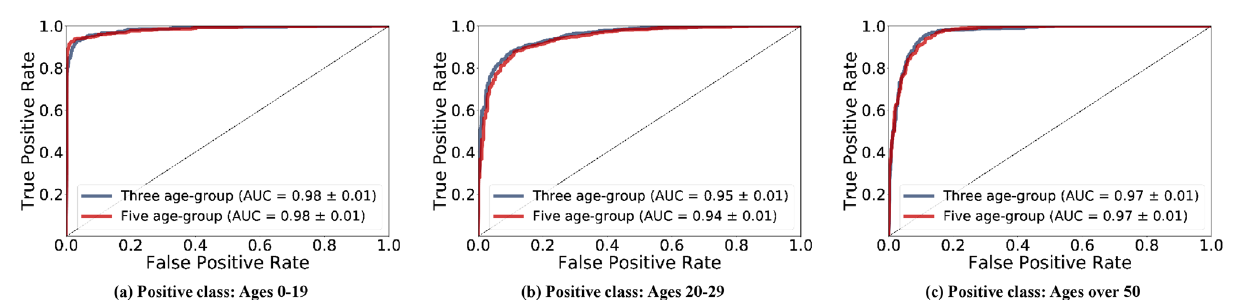
Figure 6. A comparison of average ROC curves over five-fold cross validation between the networks to obtain predictions for three age-groups and five age-groups. Each curve is obtained by binary classification to discriminate one age-group from others. The network that learned to predict five age-groups is used to predict the three age-groups. The AUC of each age-group shows (a) ages 0–19: Three-age group = 0.98 ± 0.01 and five-age group = 0.98 ± 0.01 ( p value = 0.97), (b) ages 20–49: three-age group = 0.95 ± 0.01 and five-age group = 0.94 ± 0.01 ( p value = 0.12), ( c ) ages over 50: three-age group = 0.97 ± 0.01 and five-age group = 0.97 ± 0.01 ( p value = Fig. 5a,b, the network trained to predict using the three age groups shows a higher tendency to classify teeth as being of ages 20–49 than the network trained for five age-group predictions. From Fig. 5, the trained network for the three-age-group prediction can better discriminate adults and elderly, and the trained network for five age-group prediction discriminates children, adolescents, and adults better. Figure 6 shows the patient-wise age-group prediction performance of each age group using the ROC curves and AUC scores for the discrimination of each group. AUC achieved high scores for all age groups, ranging from 0.94 to 0.98. The high AUC scores indicate that the images of first molars #16, #26, #36, and #46 contain age- related visual features, and that the CNNs successfully exploited those features to predict the correct age groups. that different age groups do not significantly affect the classification ability and accuracy scores.